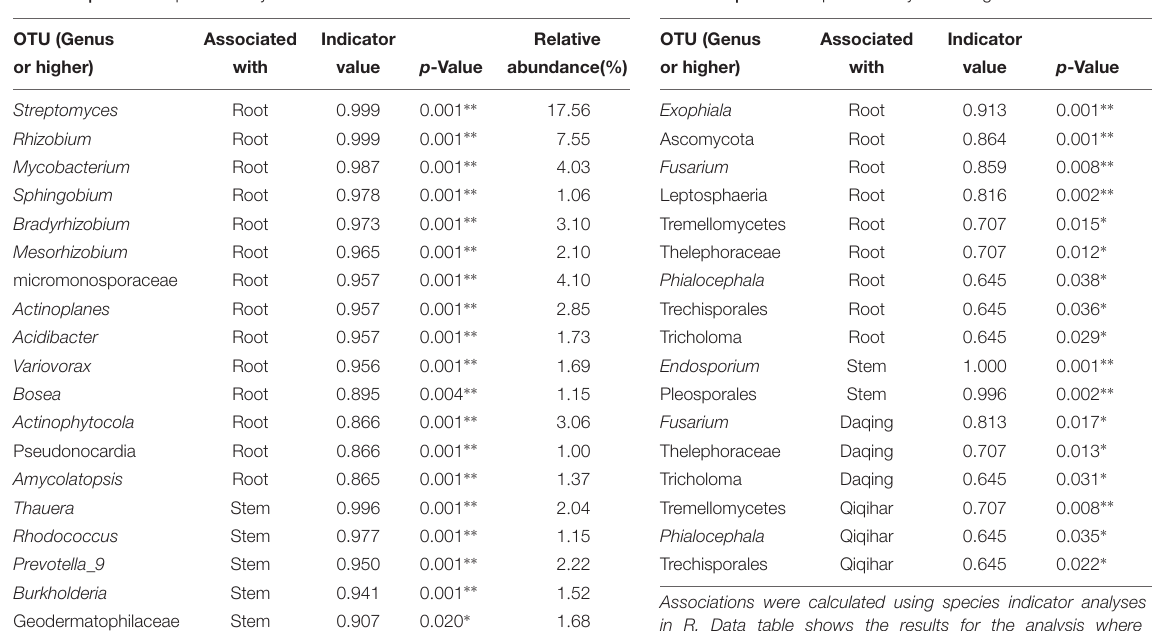
TABLE 4 | Indicator species analysis of bacteria. TABLE 5 | Indicator species analysis of